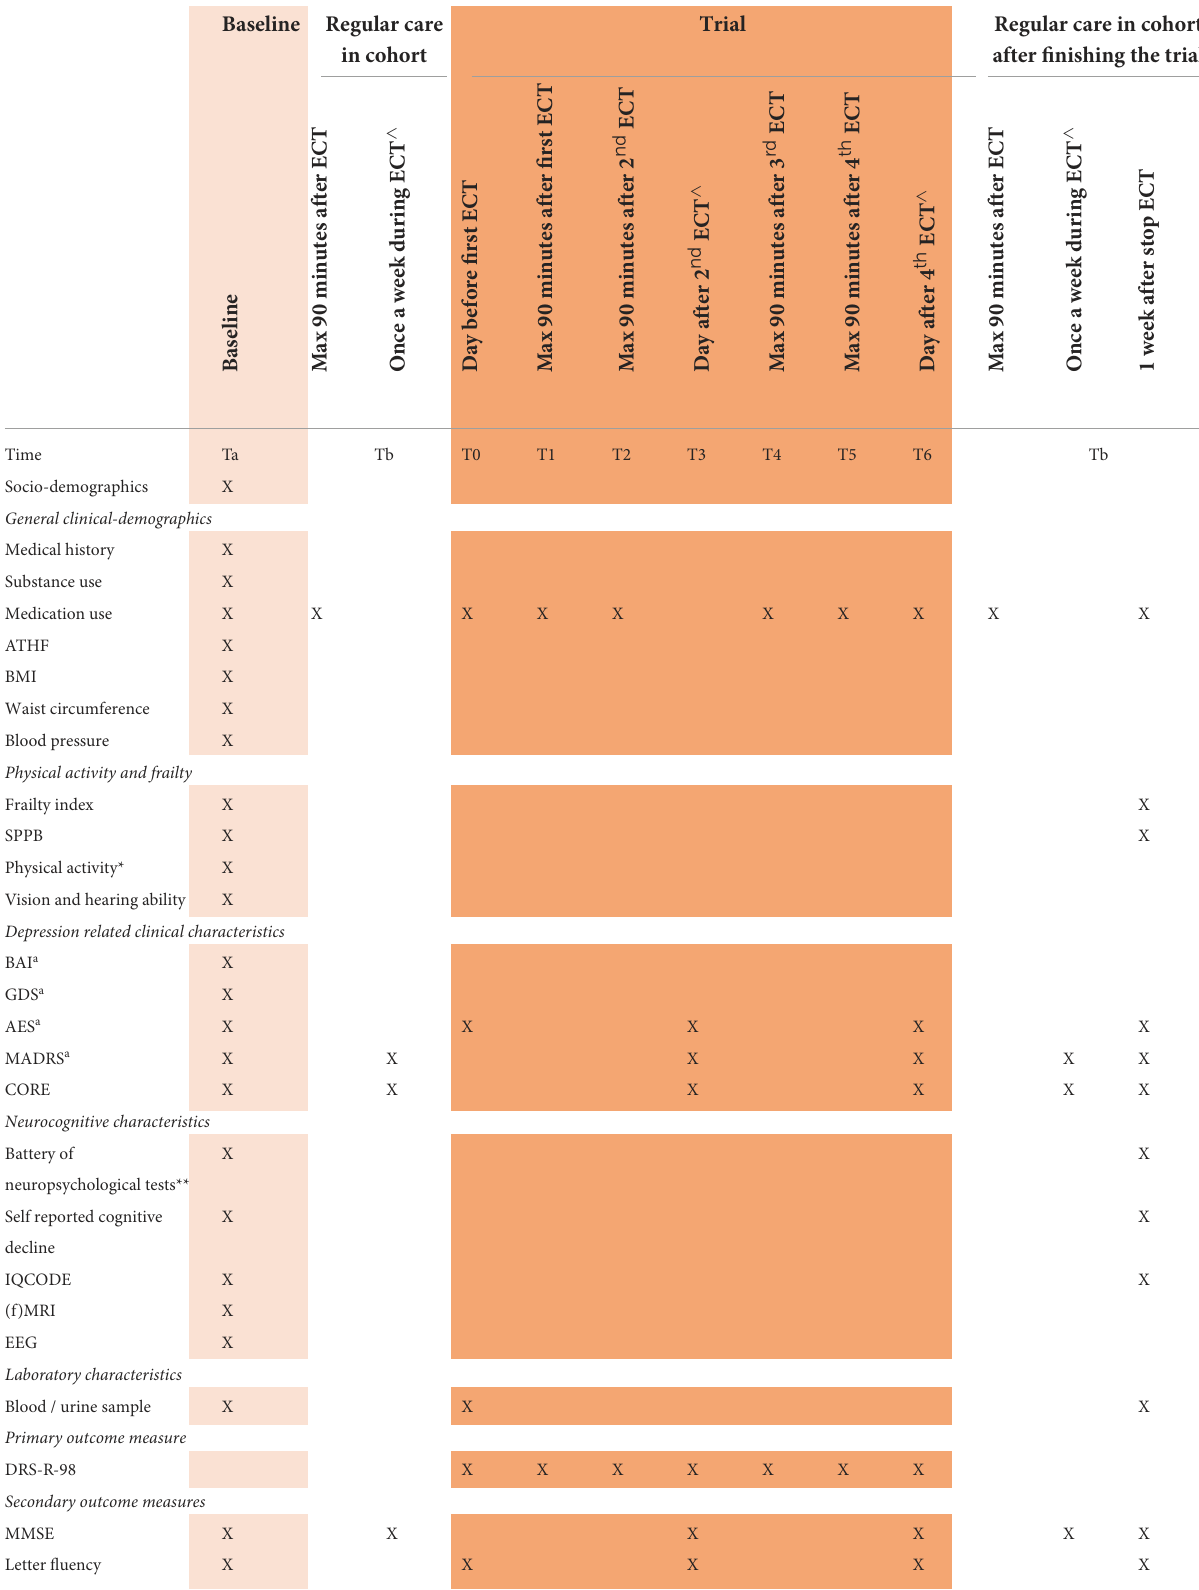
TABLE 1 Collection of patient characteristics and outcome measures in the RECALL trial and cohort. Baseline Regular care Trial Regular care in cohort in cohort after finishing the